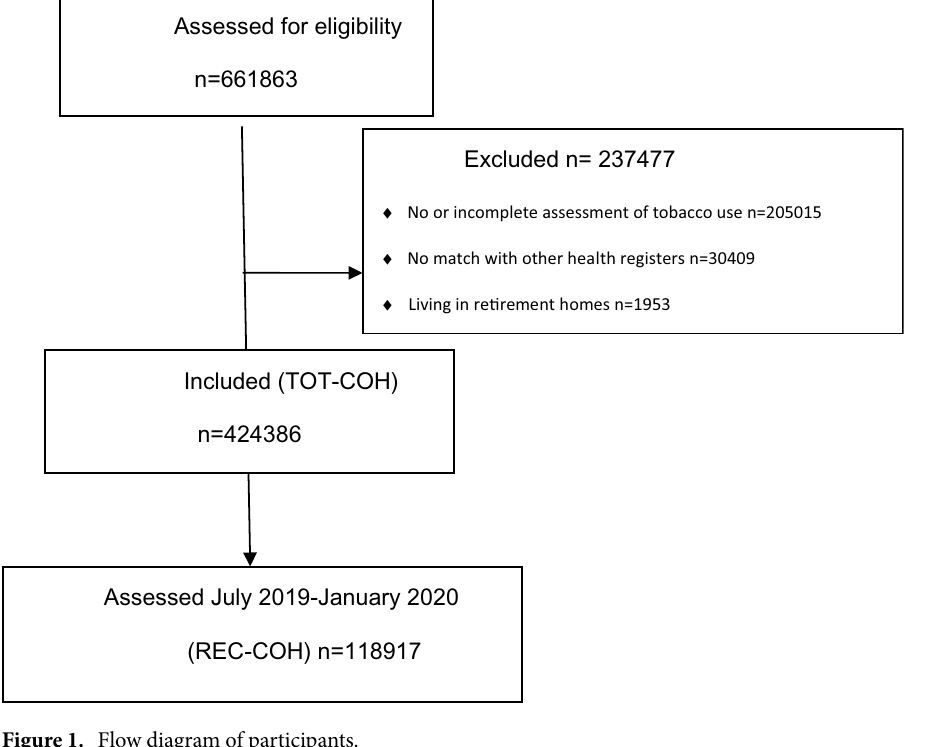
Figure 1. Flow diagram of